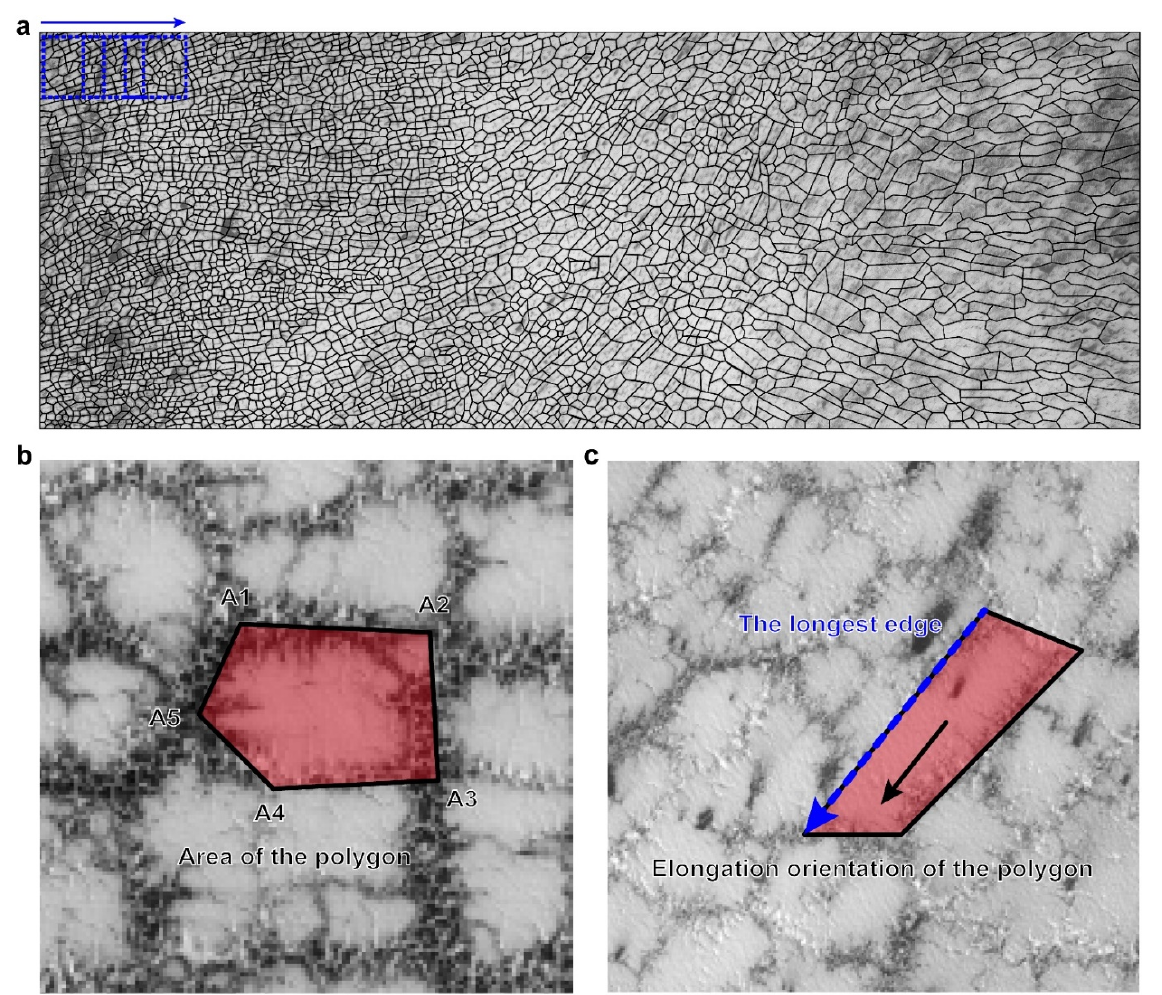
Figure 2. The procedures of image processing for the polygons. ( a ) The recognition result of the individual polygons. A series of regions are marked with a dashed box to illustrate the definition of polygon edge density. Two partially enlarged views are presented in ( b , c ) for the illustration of the recognition process of polygons. ( b ) The recognition of the polygons. The area of a polygon is shaded. The points of the polygon are marked as A i ( i = 1, 2, 3, . . . ). ( c ) Elongation orientation of the polygon (black arrow) is defined as the orientation of the longest edge (dashed